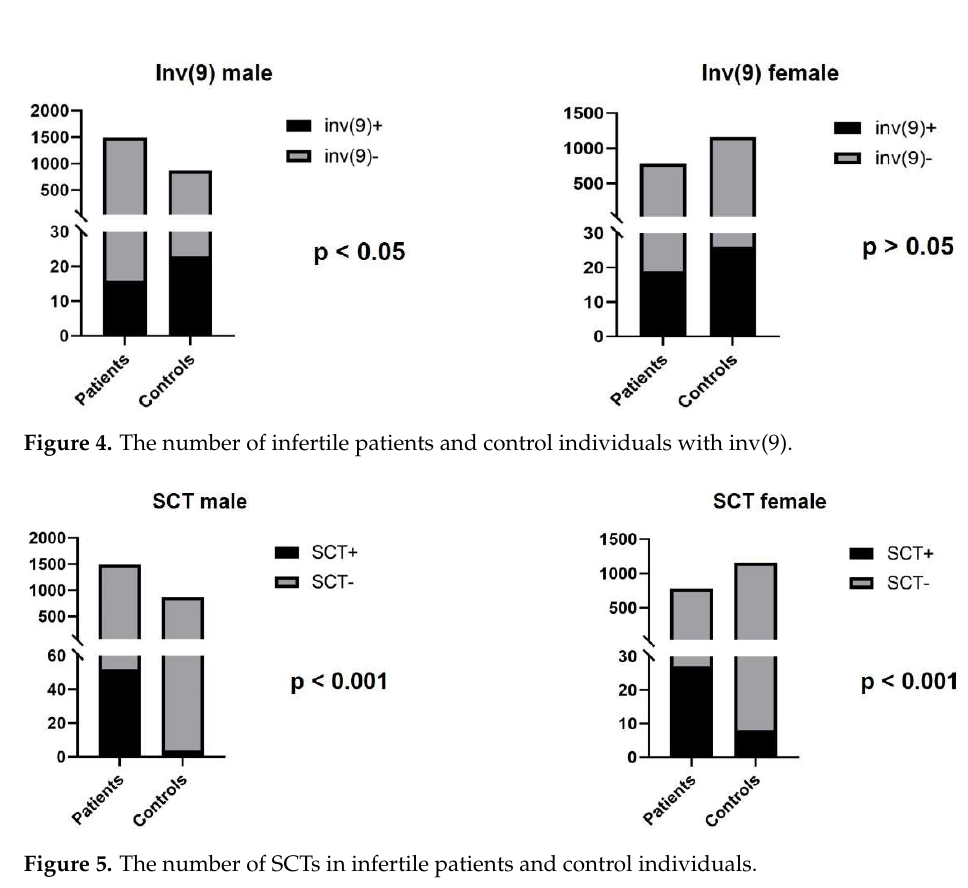
Figure 3. Karyogram of a male patient with the most frequent SCT, t(7;14).